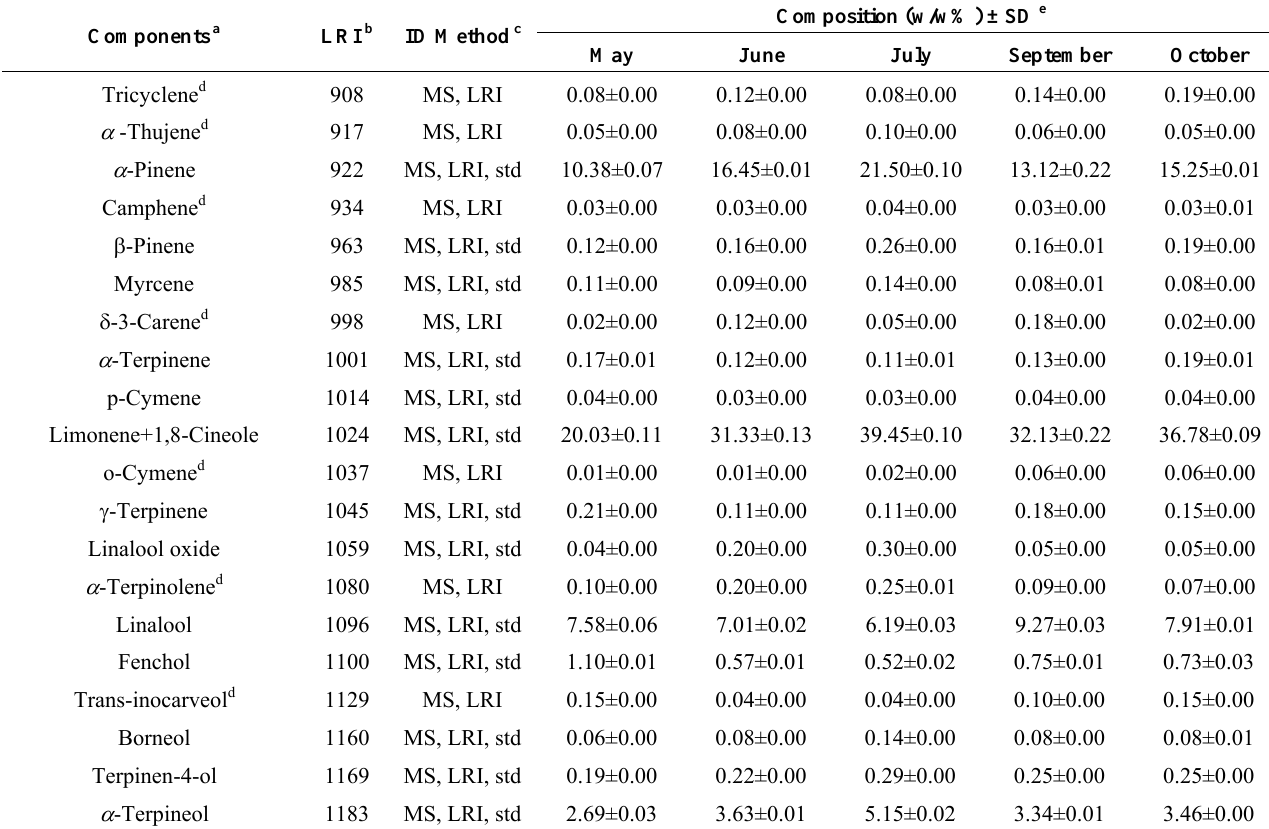
Table 2. Composition of the leaves essential oil of Portuguese